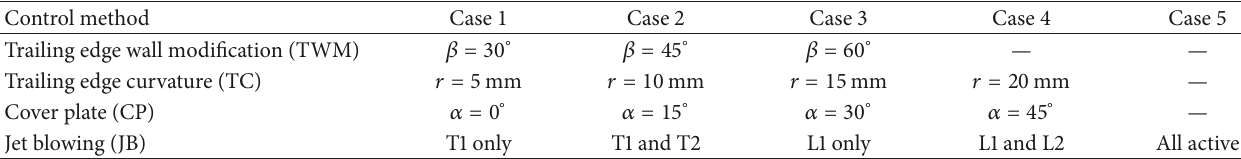
Table 3: Active and passive control